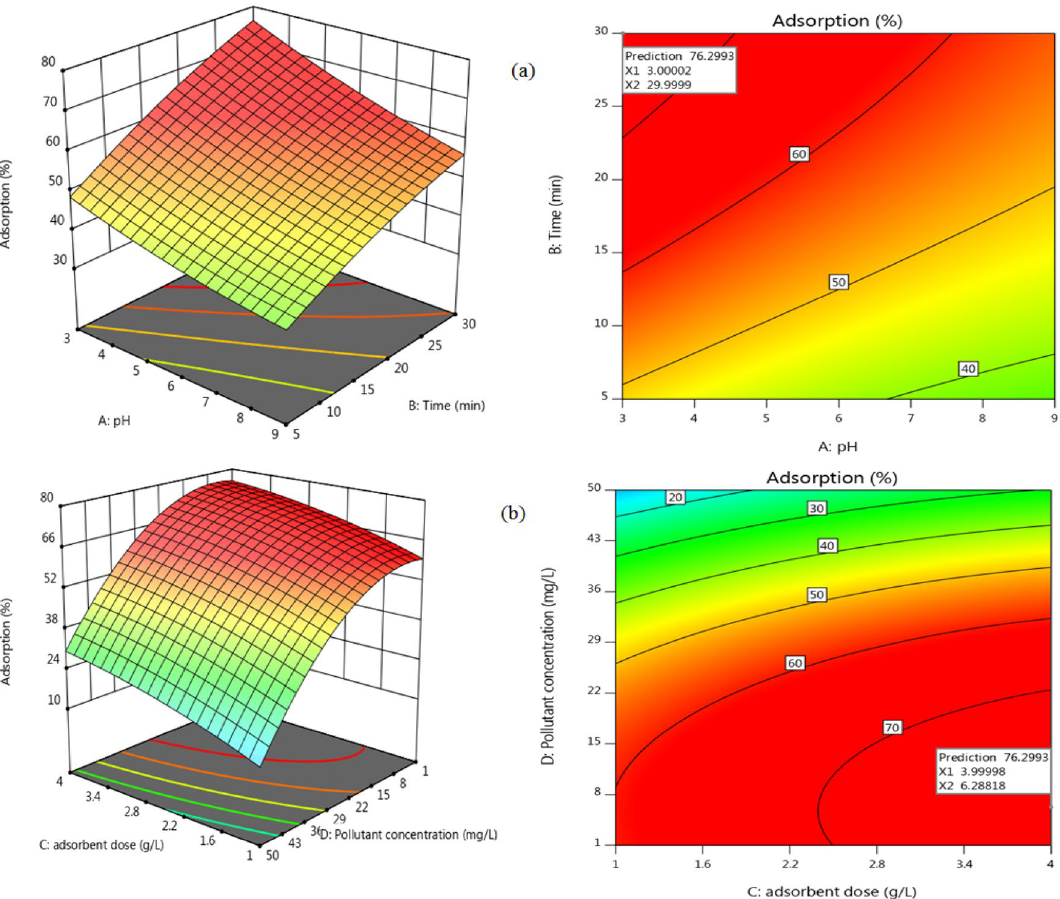
Figure 5. The 3D response surface and contour plots for diazinon removal by pumice, ( a ) pH -contact time on adsorption (initial diazinon concentration = 6.28 mg/L, and pumice dosage = 4 g/L), ( b ) pumice dosage—initial diazinon concentration on adsorption (pH = 3 and contact time = 30